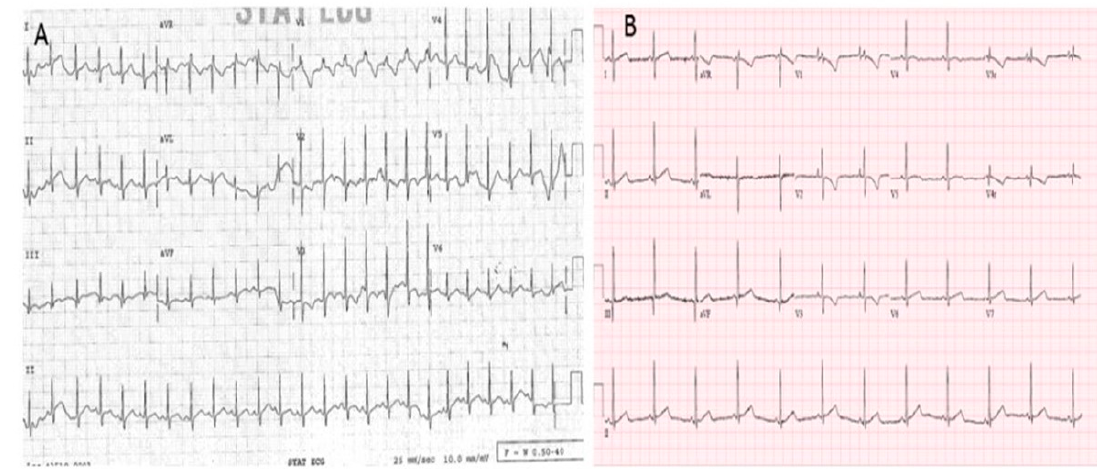
Figure 2. ( A ): A 12-lead ECG showing sinus tachycardia (150 bpm) and non-specific ST changes vs. baseline ECG ( B ): sinus rhythm with heart rate 70 bpm.